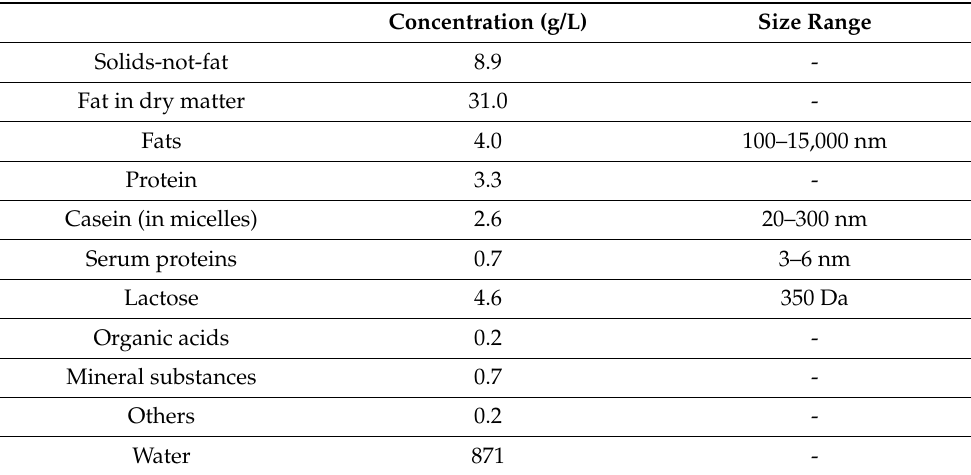
Table 2. Typical composition of whole cow milk